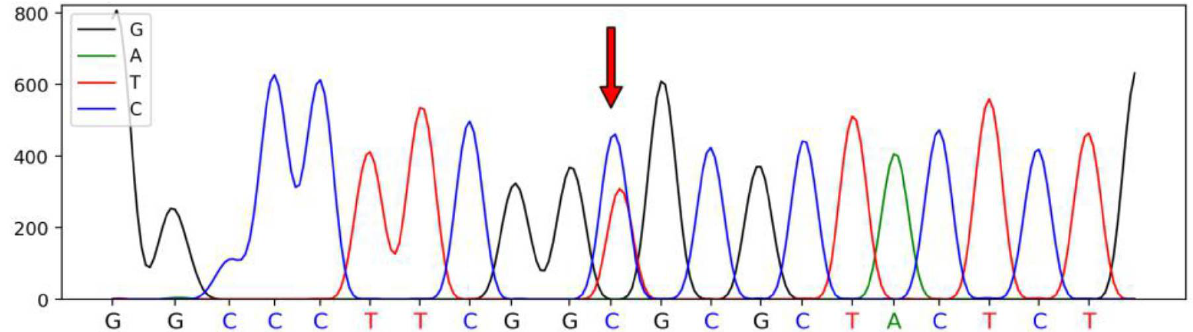
Figure 3. The sequencing peak map of the SSTR1 and the mutated SNP3 site of Hulun Buir sheep. The sites marked by the red arrow was the SNP3 mutation, which was found and identified in exon 2 of SSTR1 , C309T (rs404696179). The sequences were analyzed using DNAMAN software.